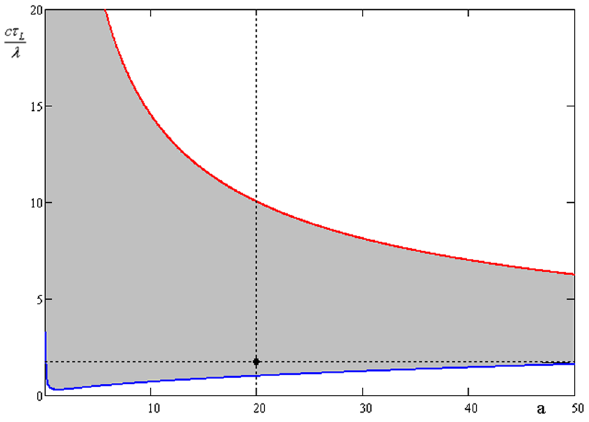
Figure 2. The range (Eq. 8, grey area) of laser parameters where magnonic oscillations of cluster plasma can be realized. Here Z = 30, A = 196, η = 0.2, R 0 = 100 nm, (cid:31) = 1000 nm , and p = 4 R 0 . The distance between the nearest clusters is R 12 = 2 p = 800 nm . The black dot shows the laser pulse of 6 fs and 5.6 × 10 20 W/cm 2 , used in our PIC simulations.